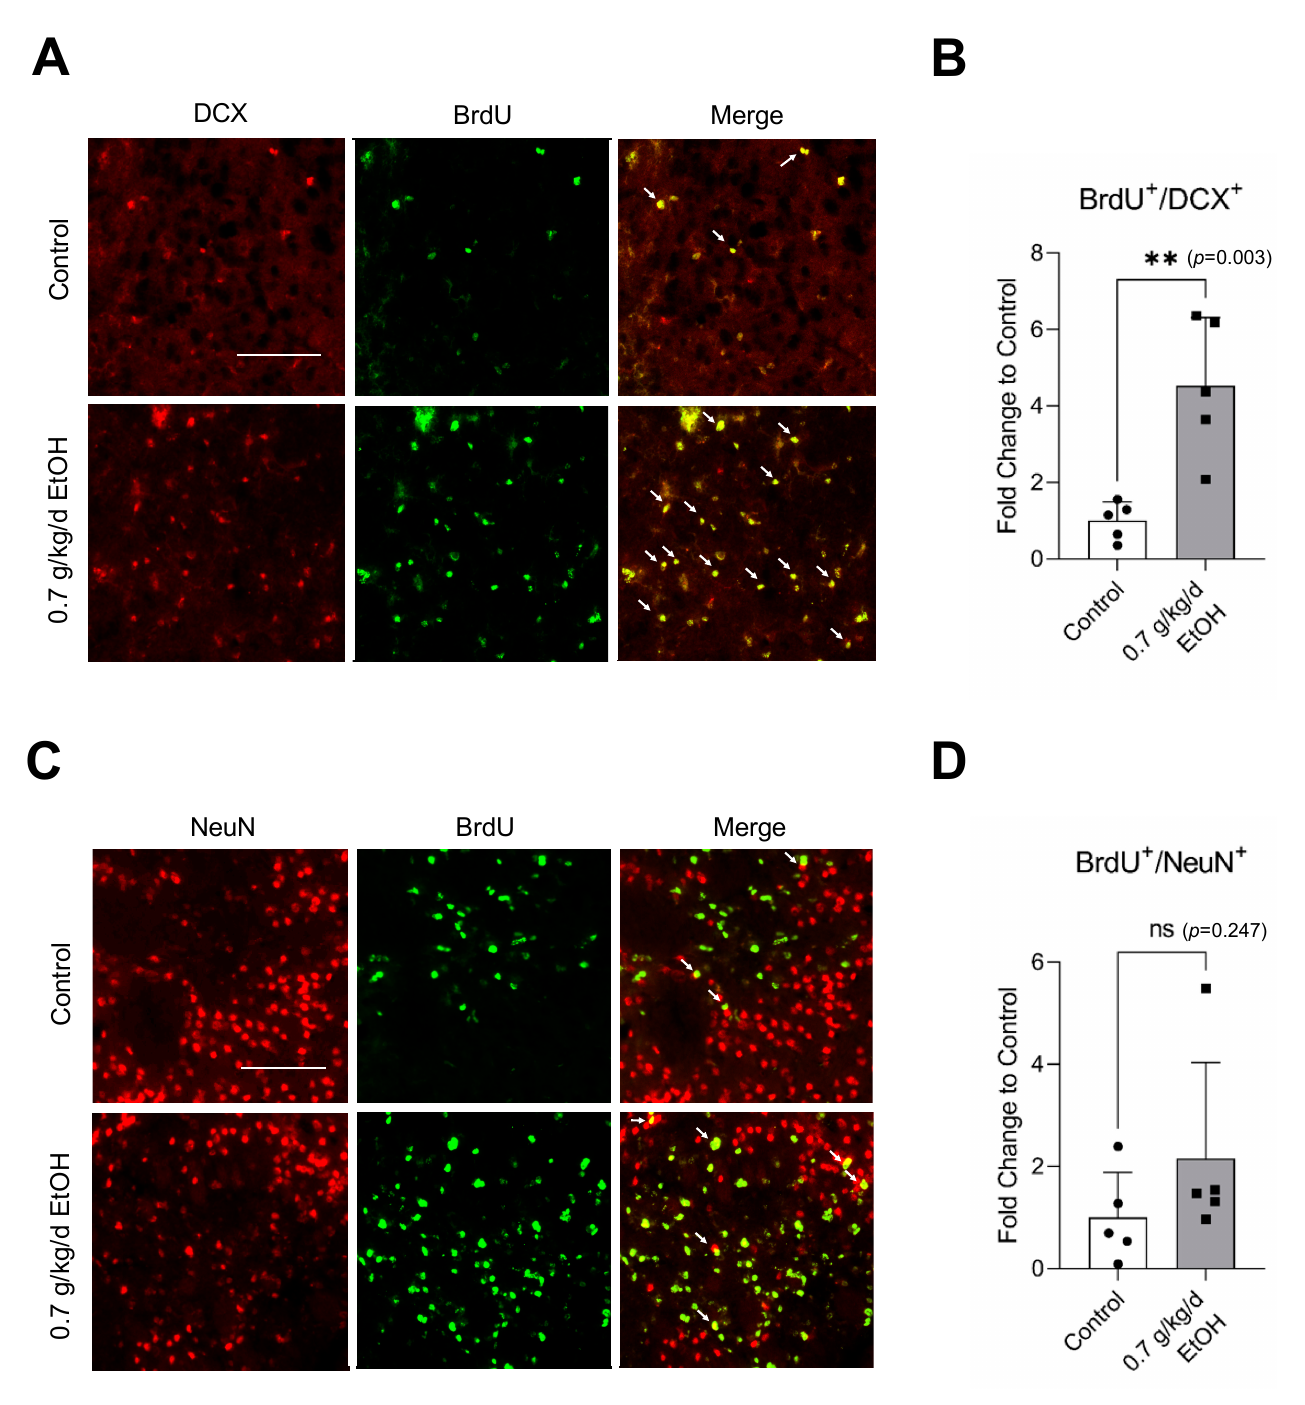
Figure 7. Effect of LAC on postischemic neurogenesis in the ischemic striatum. ( A ) Representative double staining of BrdU and DCX. Scale bar = 100 µ m. ( B ) Values are means ± SD ( n = 5). ( C ) Representative double staining of BrdU and NeuN. ( D ) Values are means ± SD ( n = 5); ** p < 0.01 vs. Control. Analyzed using an unpaired t -test.